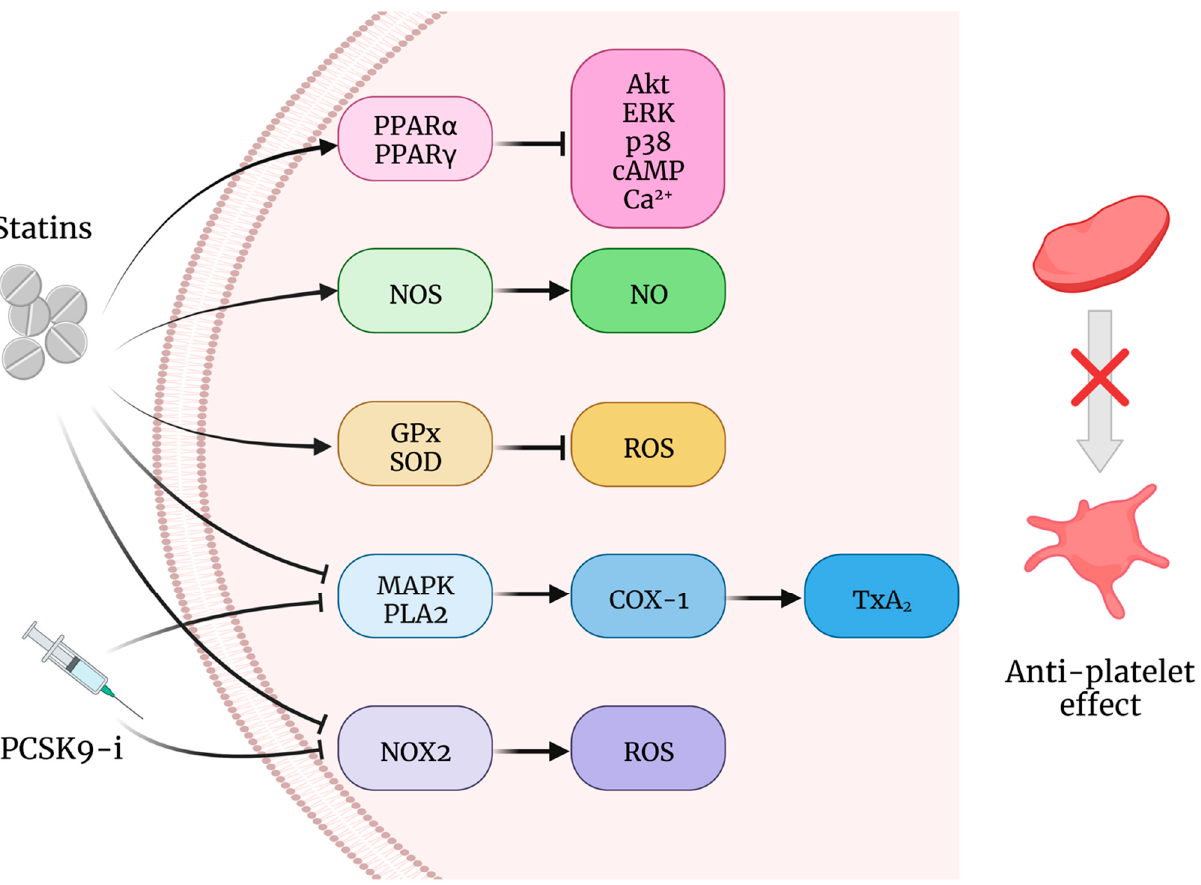
Figure 3. Effects of statins and PCSK9 inhibitors on platelet redox balance. Abbreviation: PCSK9-i: PCSK9 inhibitors; PPAR α : peroxisome proliferator-activated receptor alpha; PPAR γ : peroxisome proliferator-activated receptor gamma; NOS: nitric oxide synthase; GPx: glutathione peroxidase; SOD: superoxide dismutase; MAPK: mitogen-activated protein kinase; PLA2: phospholipase A2; Nox2: NADPH oxidase 2; Akt: Protein kinase B; ERK Extracellular signal-regulated kinase; cAMP: cyclic adenosine monophosphate; NO: nitric oxide; ROS: reactive oxygen species; COX-1: cyclooxygenase 1; TxA2: thromboxane A2.